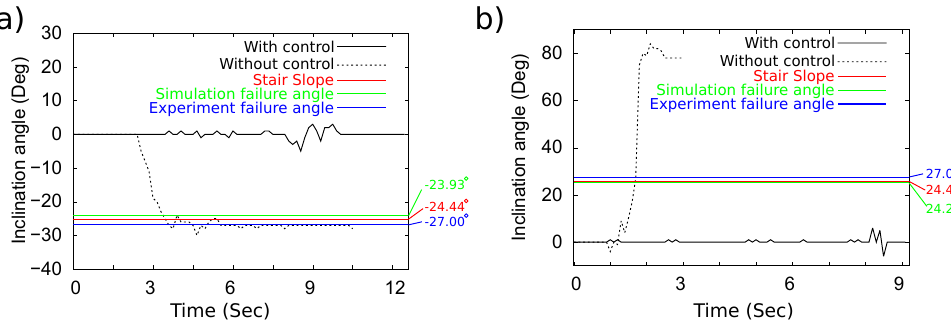
Figure 21. Comparison of the inclination angles of the prototype between with and without control experiments during ( a ) ascending on the stairs; ( b ) descending on the